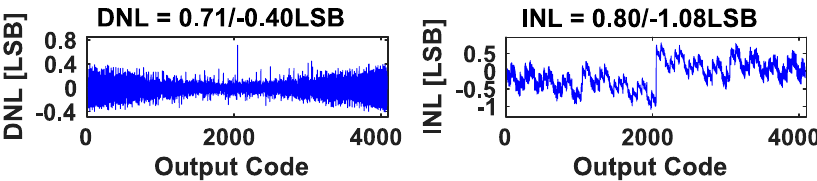
Figure 19. The measured DNL and INL of the SAR ADC with the SCRD.